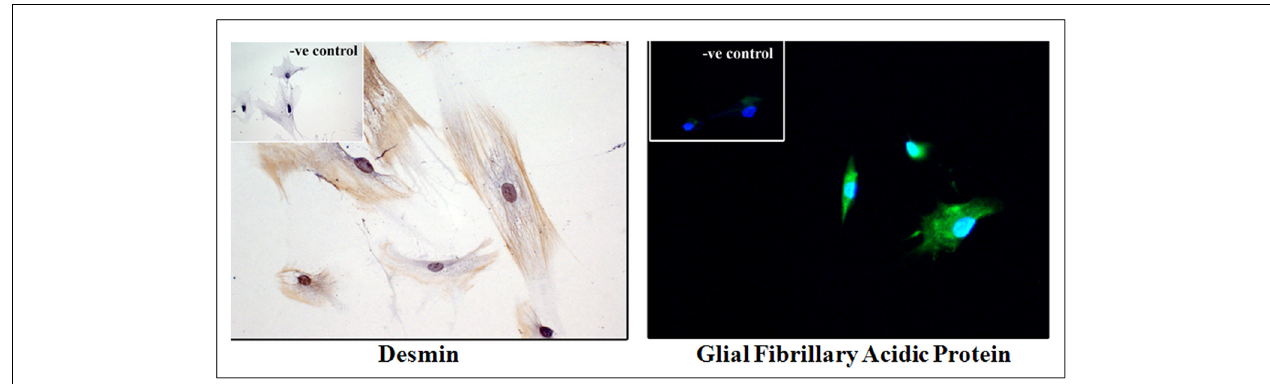
FIGURE 2 | Human pancreatic stellate cells (PSCs) in culture. Immunocytochemical analysis of primary cultures of human PSCs exhibiting desmin and glial fibrillary acidic protein (GFAP) staining. Insets: Negative control ( previously unpublished figure